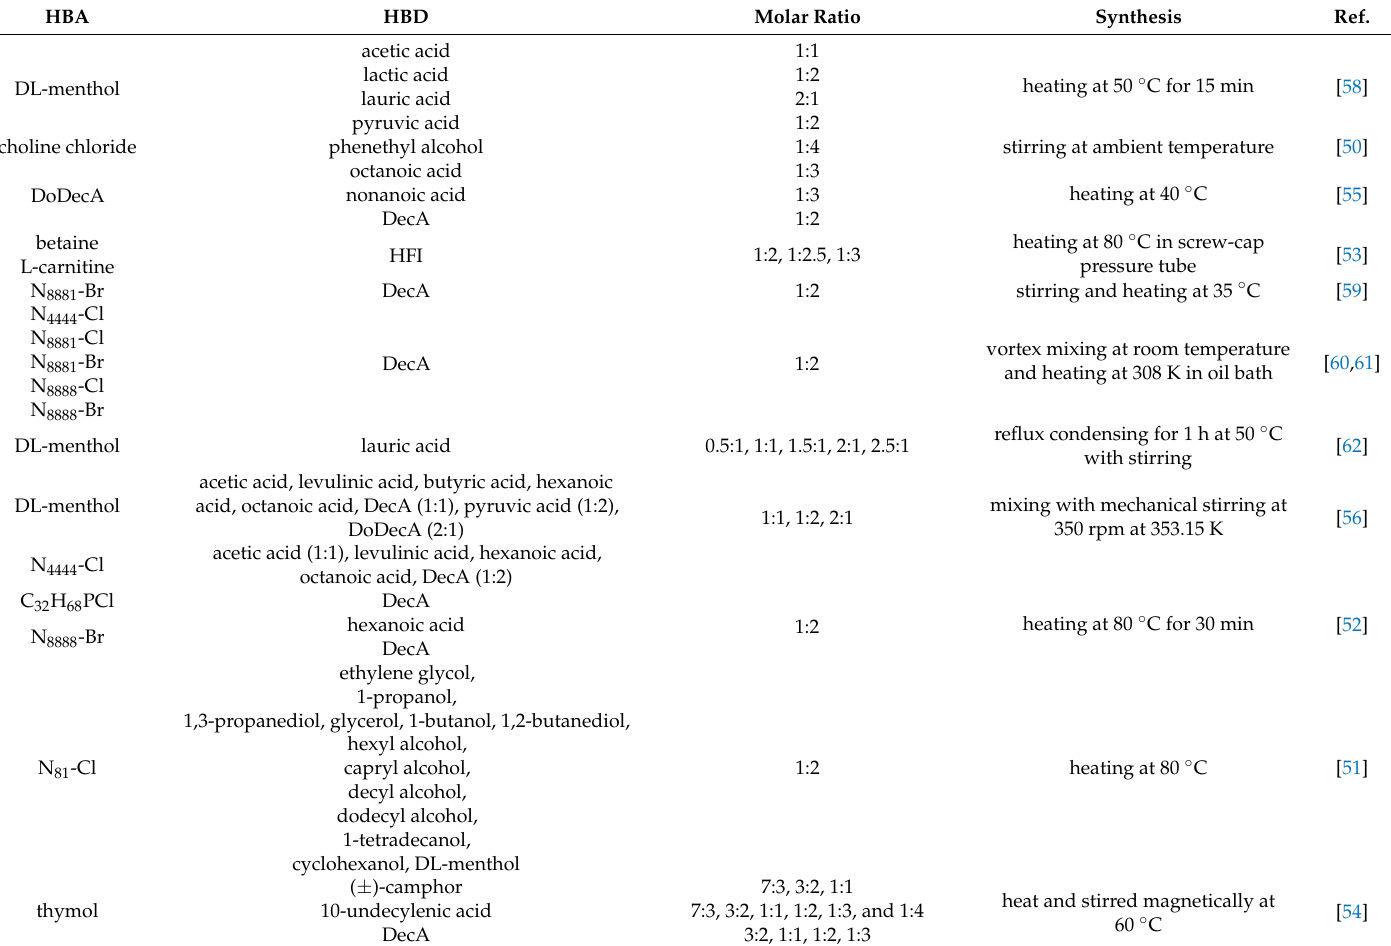
Table 2. Synthesis of HDES by combining HBA and